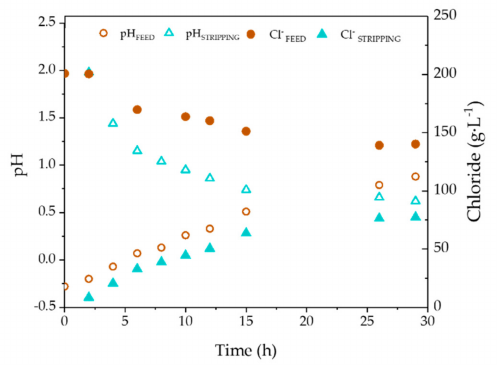
Figure 5. Evolution of pH and chloride concentration with experimental time in the feed and stripping phases using NDSX technology in a representative experiment (EXP III).